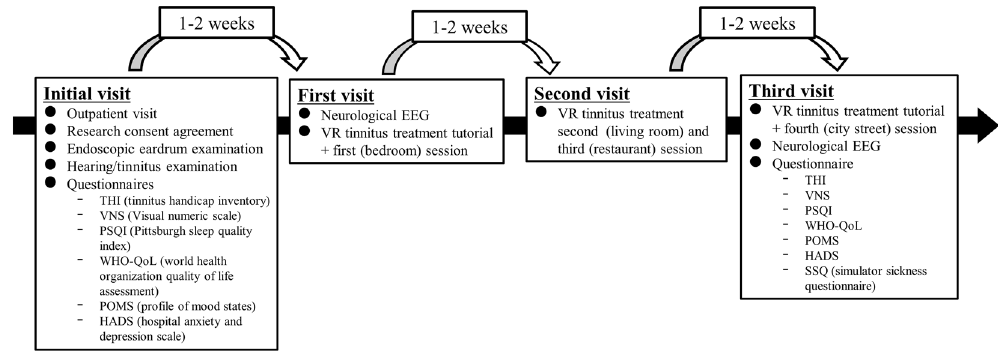
Figure 3. The four stages of the experimental protocol.